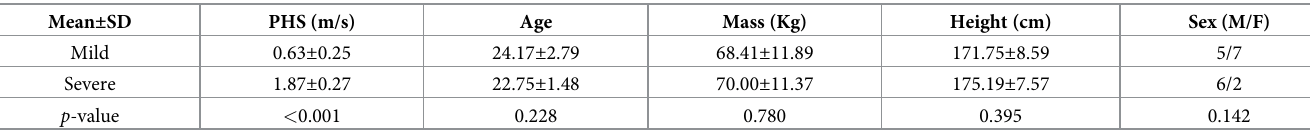
Table 1. Different severity groups’ information. Please note that there was no significant difference in any of the variables at level of 0.05 ( p -value > 0.05), except PHS.